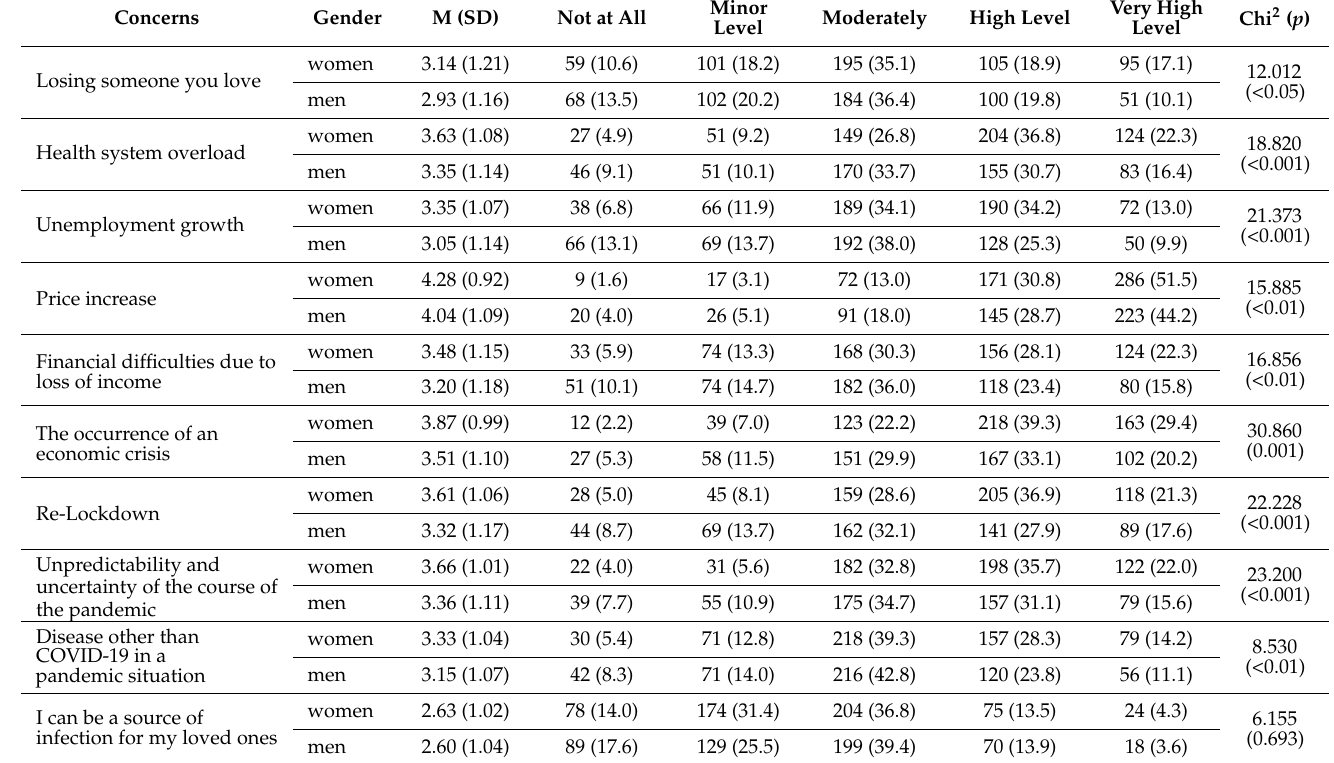
Table 4. Individual items of Concerns Checklist (M, SD, and frequencies) by gender (n = 1060; n